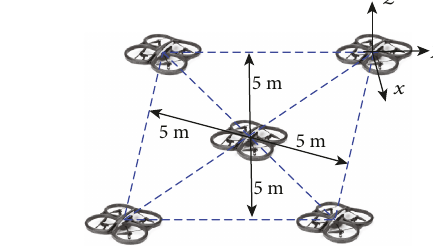
Figure 9: Test performance of RNN. Table 2: Constraints of the system states and control